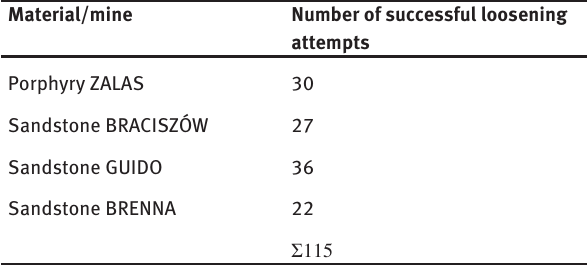
Table 2: Number of successful rock loosening